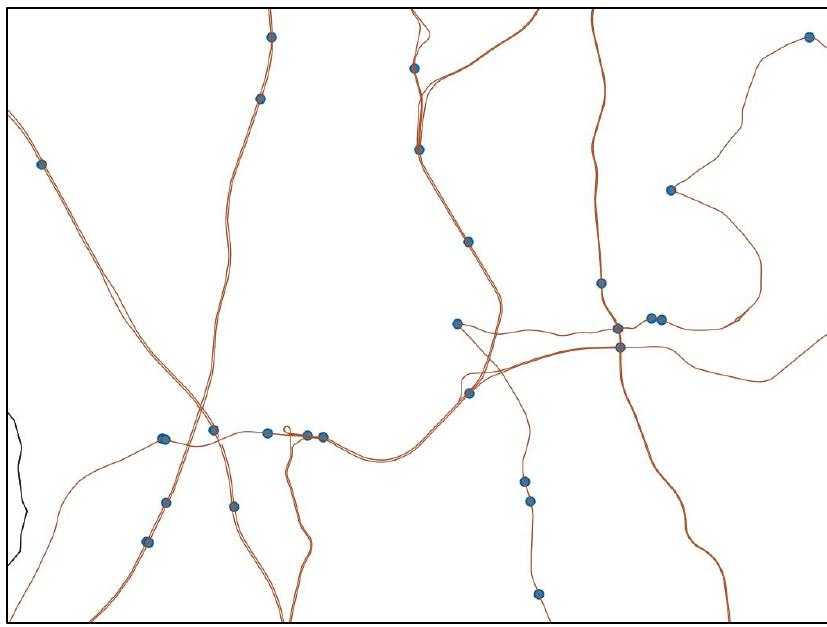
Figure 6. Disparity pattern in a region, Seoul using